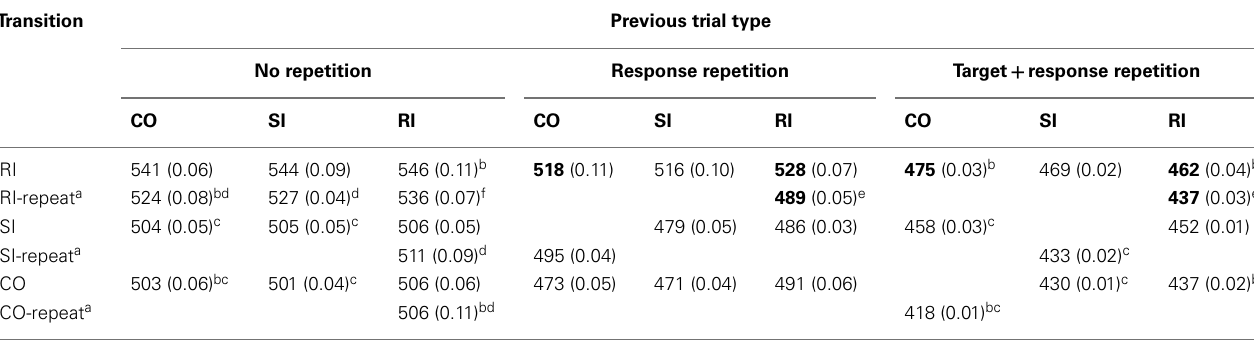
Table 1 | Mean correct response times (in ms) and error rates (in brackets), separated by flanker repetition.